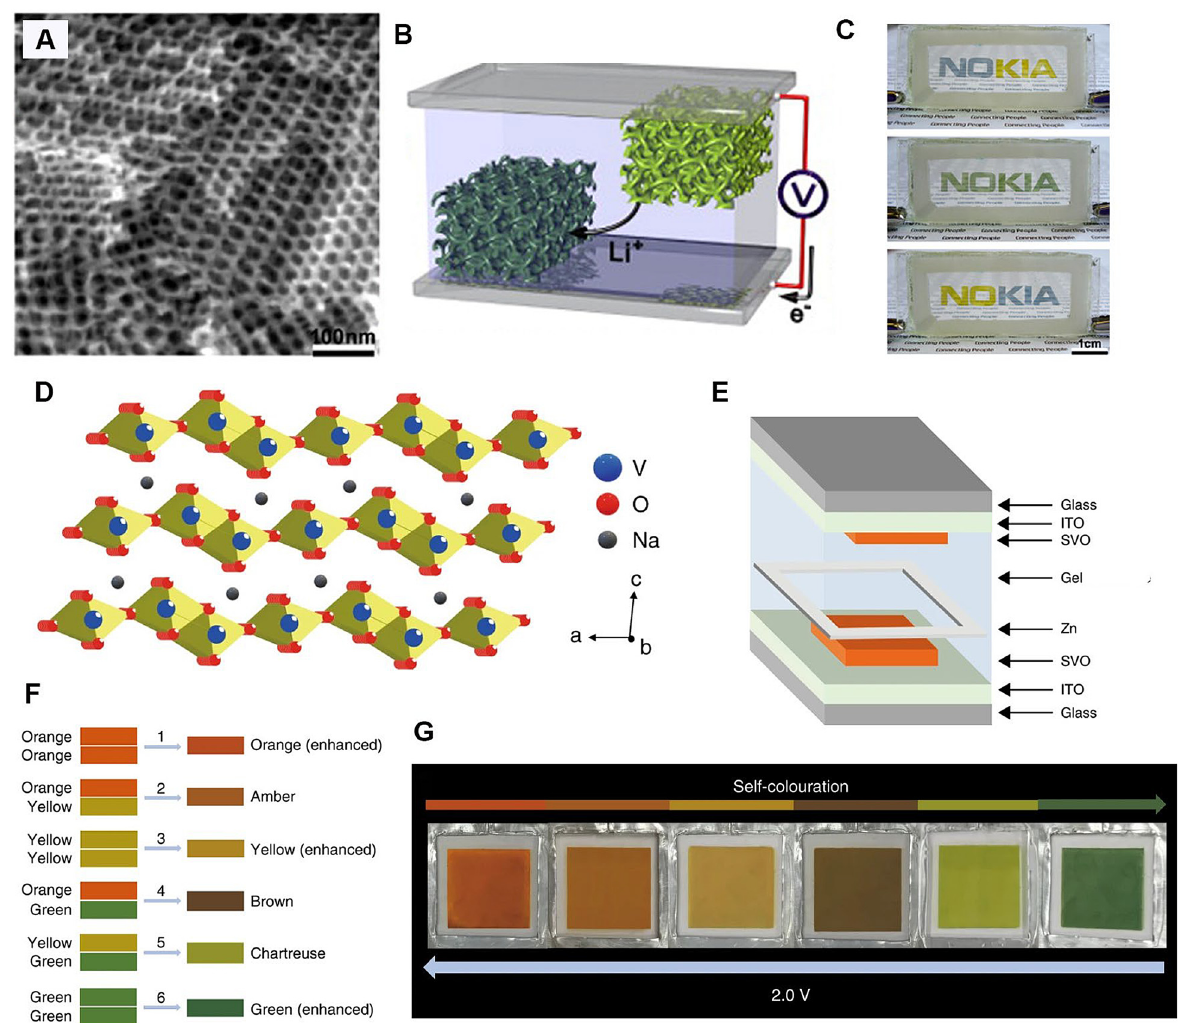
Figure 11: Structure and characterization of vanadium oxide-based electrochromic displays. (A) Scanning electron microscope (SEM) of a mesoporous V 2 O 5 double-gyroid fi lm on an FTO substrate (B) Schematic illustration of the electrochromicsupercapacitordesignbasedontwolaterallyoffsetdouble-gyroidstructuredelectrodes.(C)Photographsofanelectrochromic supercapacitordevicedisplayingcolorchangeonchargeanddischarge.Theletters “ NO ” formthedouble-gyroidstructuredtopelectrodeand “ KIA ” form the bottom electrode. (A – C) Reproduced with permission from Ref. [171]. Copyright 2012, American Chemical Society. (D) Crystal structure of the SVO nanorods. (E) Schematic illustration of the Zn – SVO electrochromic display. (F) Schematic illustration of the color overlay effect via the combination of orange, yellow, and green colors. (G) Digital photographs of the Zn – SVO display showing six colors obtained through the color overlay effect. Reproduced with permission from Ref. [16]. Copyright 2020, Nature Publishing